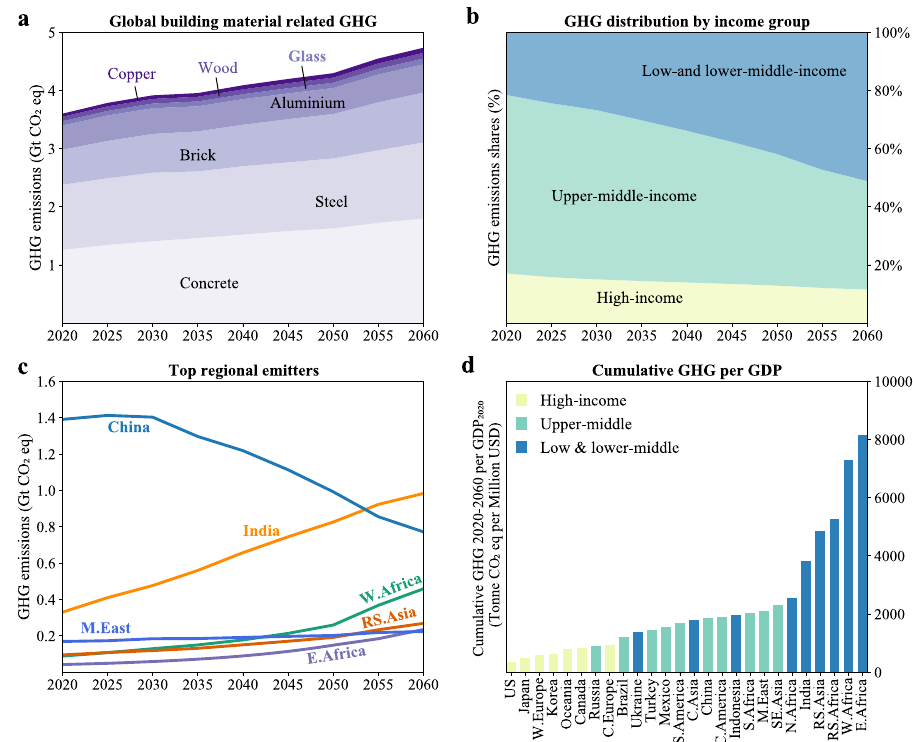
Fig. 1 Greenhouse gas (GHG) emissions from building materials use for global regions in the Baseline scenario. a Development of global GHG emissions for seven materials during 2020 – 2060. b Percentage evolution of GHG emissions for three income groups during 2020 – 2060. c Development of emissions in the top 6 emitting regions (by 2060), occupying over 60% of the total, during 2020 – 2060. d Expected cumulative GHG emissions